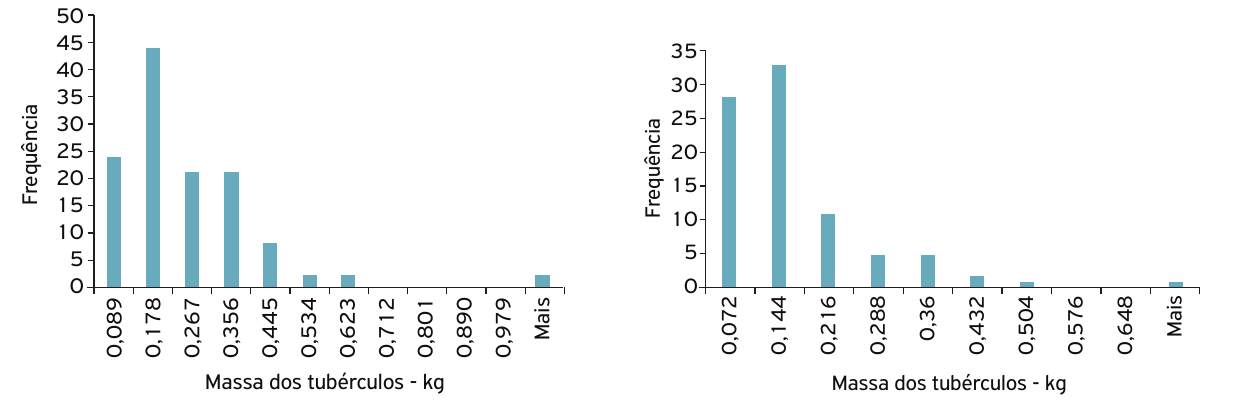
Figura 1. Frequência da massa dos tubérculos produzidos a partir de plantas sem vírus. Presidente Prudente, São Paulo, 2012.